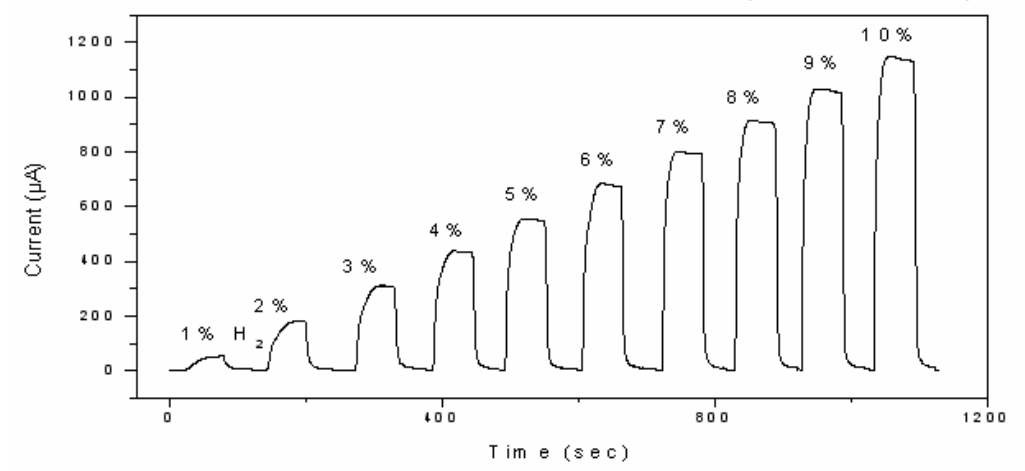
Figure 6. Response behaviour of the Pt | Nafion electrode sensor element with an area of 2 cm 2 prepared from 0.01 M Pt(NH concentration range of